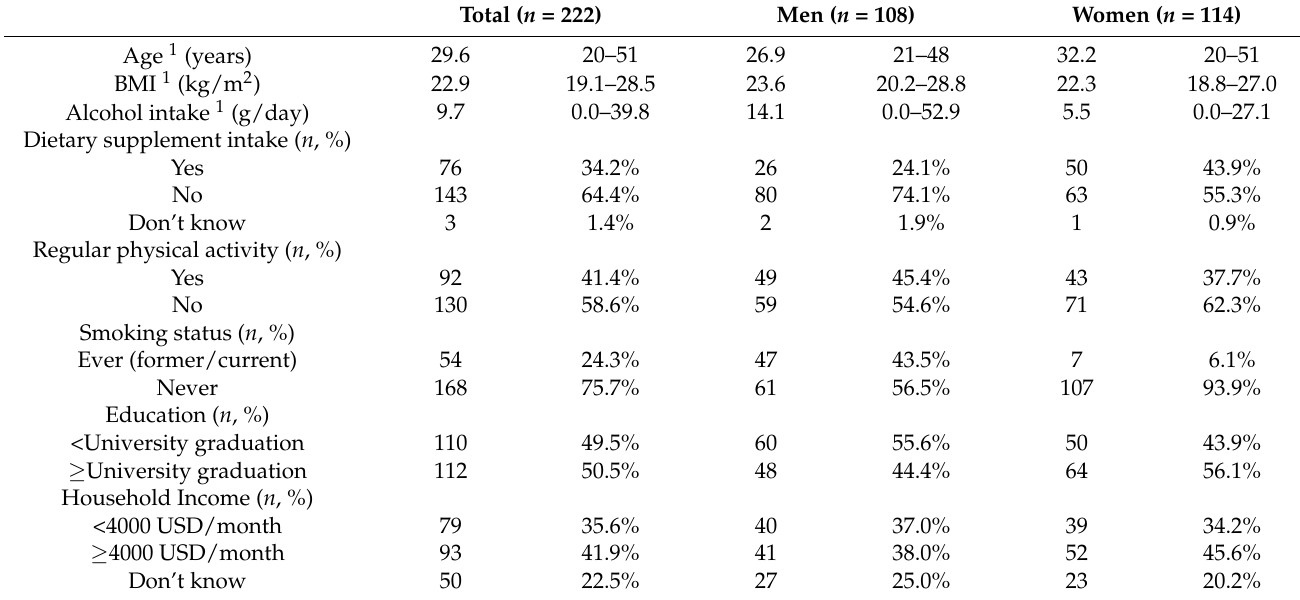
Table 1. General characteristics of Korean adults of the National Institute of Agricultural Sciences of Korea and the International Agency for Research on Cancer (NAS-IARC) cross-sectional study ( n = 222